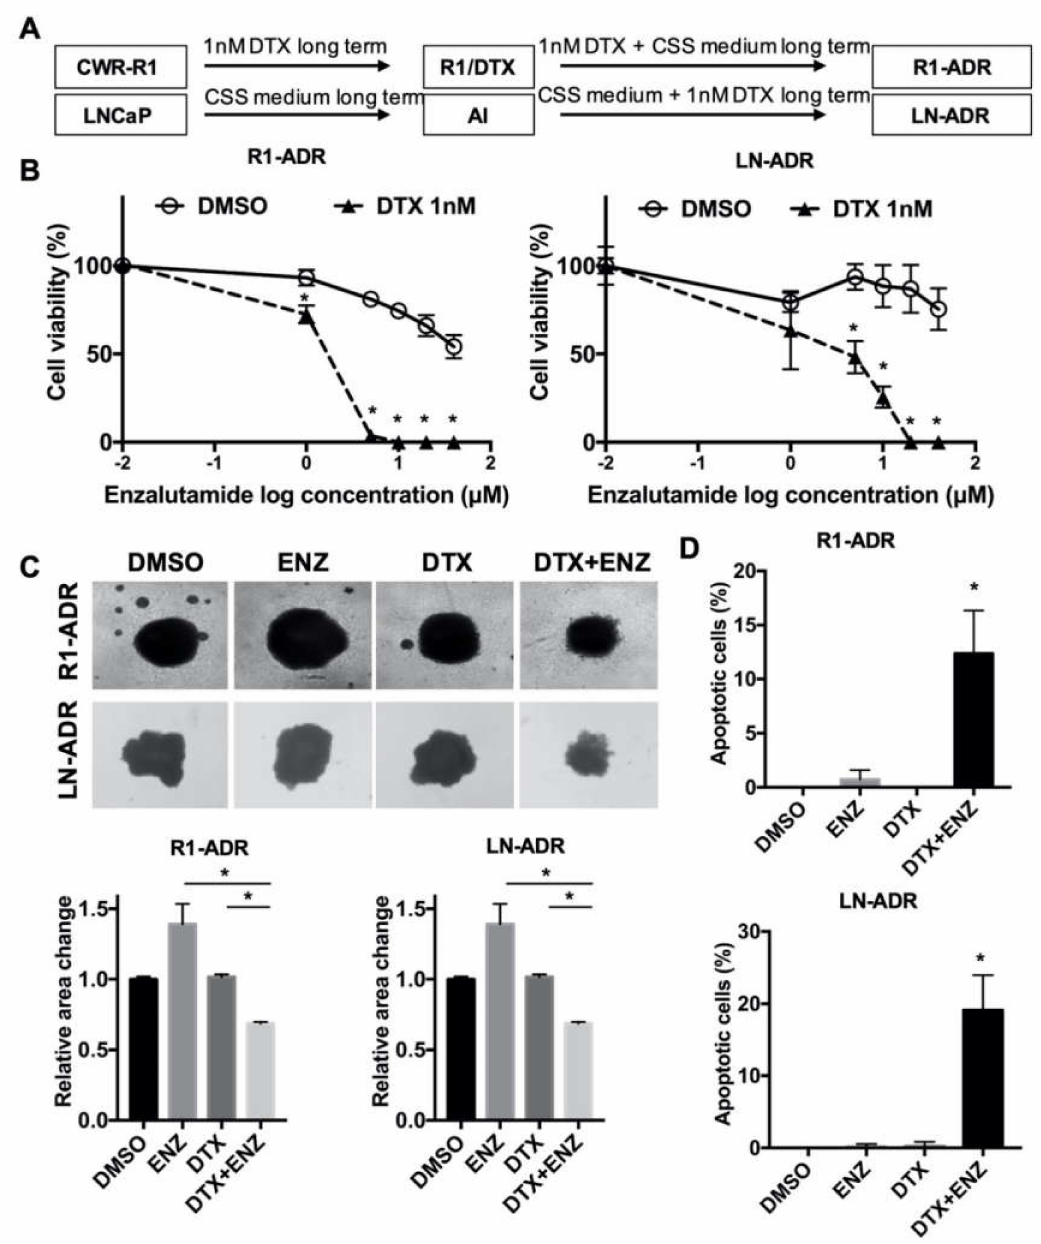
Figure 1. DTX-ENZ combined treatment inhibited growth of drug resistant R1-ADR and LN-ADR cells. ( A ) Schematic diagram of the establishment of drug resistant cell lines. ( B ) Cell growth was determined by CCK-8 assays. R1-ADR (left panel) and LN-ADR (right panel) cells were treated with di ff erent doses of ENZ for 6 days with or without 1nM DTX. ( C ) Morphology (upper panel) and quantification (lower panel) of tumor spheroids after 14 days of treatment with 40 µ M ENZ and / or 2nM DTX (R1-ADR) or 4nM DTX (LN-ADR). ( D ) TUNEL assays were performed to detect apoptosis under the indicated treatments in R1-ADR (upper panel) and LN-ADR (lower panel) cells after 48 h treatment. Cells were treated with 1nM DTX and 10 µ M ENZ (R1-ADR) or 20 µ M ENZ (LN-ADR). Error bars, S.D. * p <